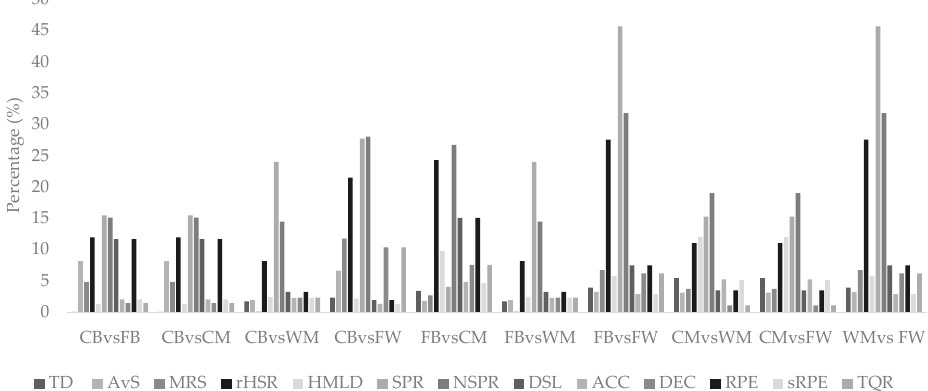
Figure 4. Mean training load and recovery status per session according to comparison between playing positions.